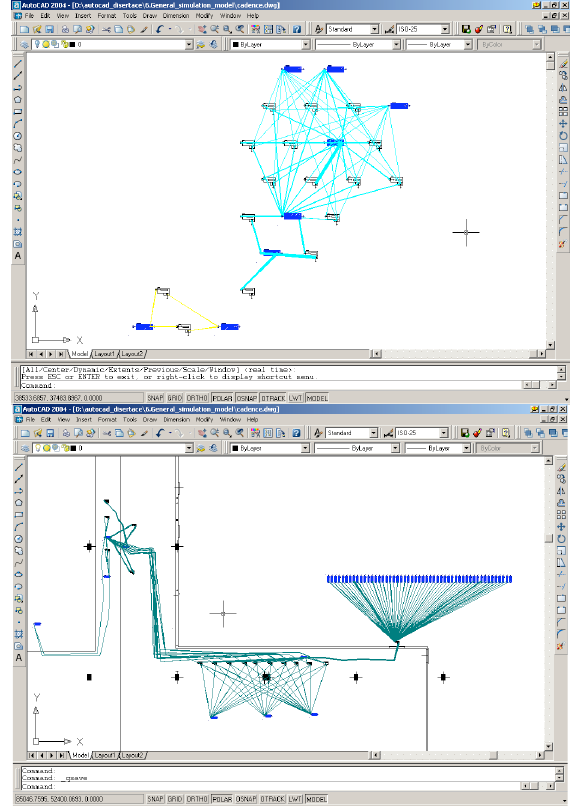
Fig. 6. Snapshots of layout from AutoCAD for a model with material flows (ideal and real)